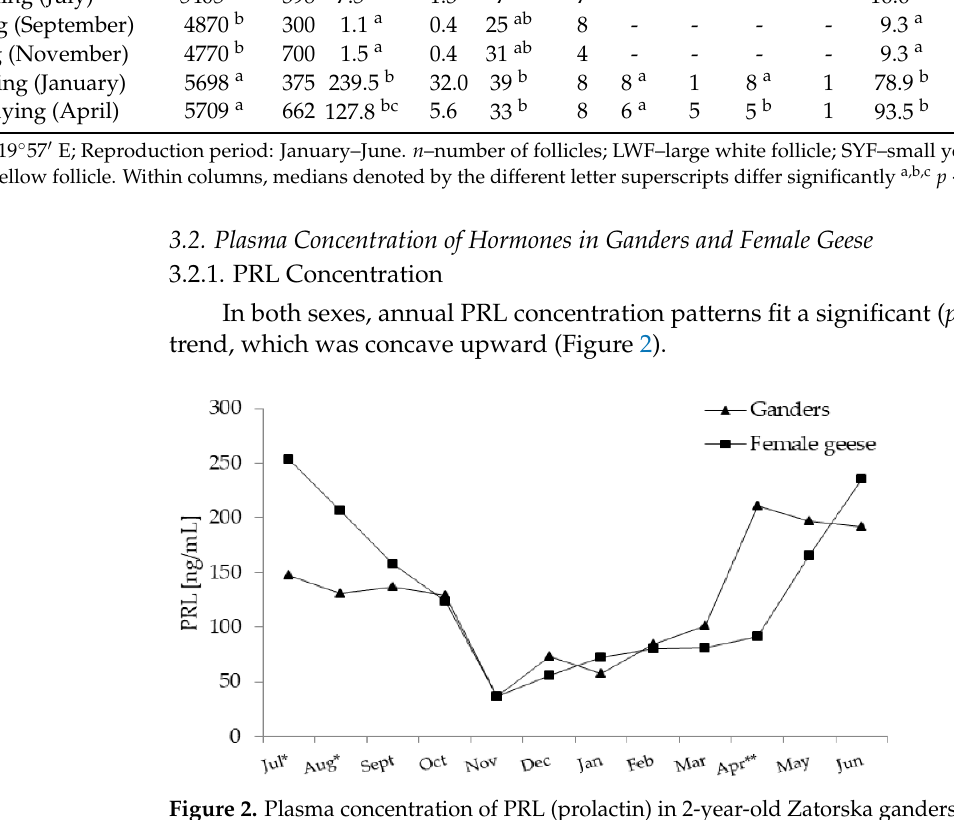
Figure 2. Plasma concentration of PRL (prolactin) in 2-year-old Zatorska ganders ( n = 10) and female geese ( n = 19) during the annual period. Breeding flock (10 ganders and 40 female geese; natural mating). Reproduction period: January–June. Photoperiod during reproduction: short-day (SD) 10 L:14 D. Data are means presented in monthly intervals. Annual pattern of PRL in ganders and female geese fit a quadratic trend ( p < 0.01). The months with different superscripts indicate significant differences between means for sex—ganders vs. female geese * p < 0.05; ** p < 0.01).